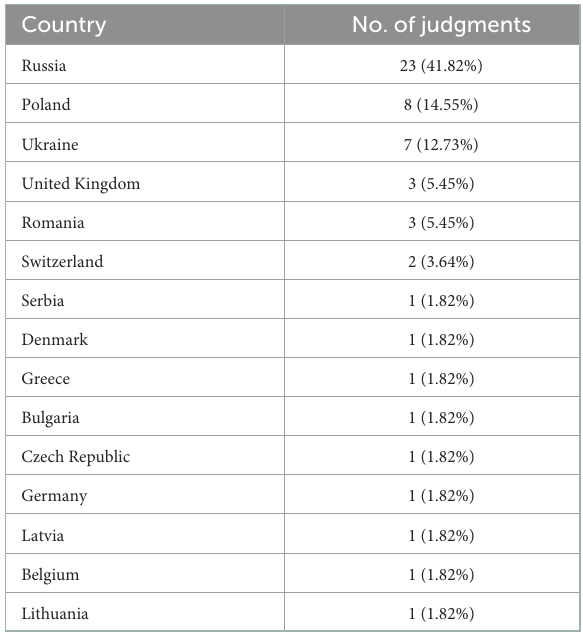
TABLE 1 Overview of the countries the analyzed judgments derive from and numbers of analyzed judgments.